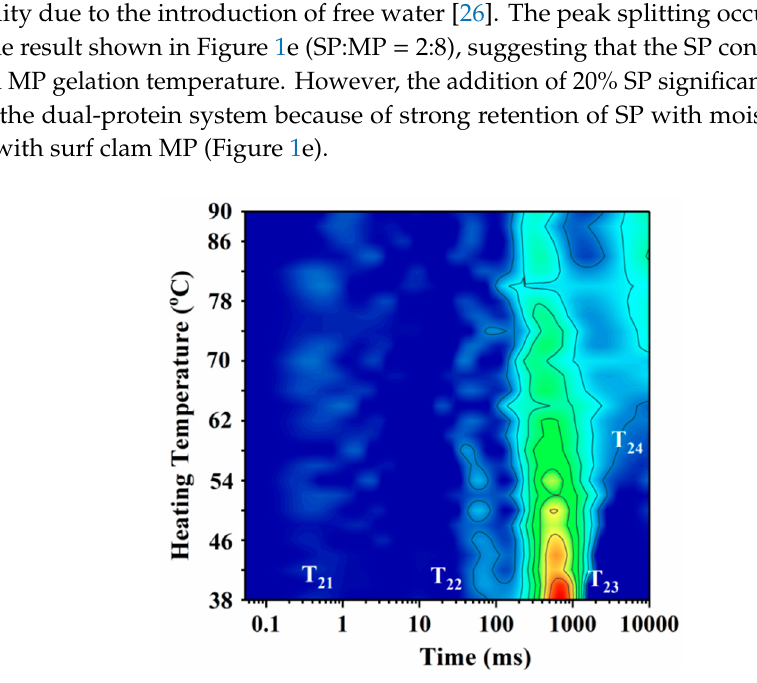
Table 1. Low field nuclear magnetic resonance (LF-NMR) parameters of T 2 relaxation times and peak area (P) of the dual-protein system with various SP/MP proportions before and after 90 °C heating for 1 h.